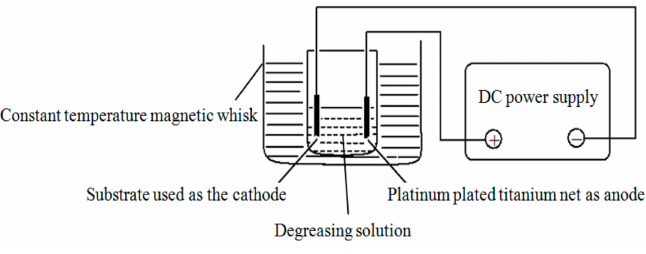
Figure 2. Electrochemical degreasing device. Table 1. Solution formulas and process parameters of the degreasing